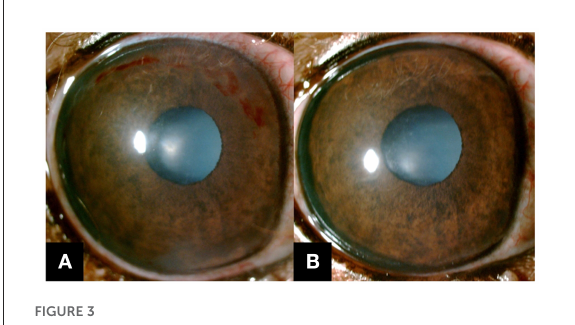
FIGURE3 Slit-lamp biomicroscope images were obtained after the removal of the contact lens. (A) After a week, ICH was still present in the superior cornea, but the rest was resolved. (B) After a month, complete resorption of ICH was observed, and the epithelium of the cornea appeared